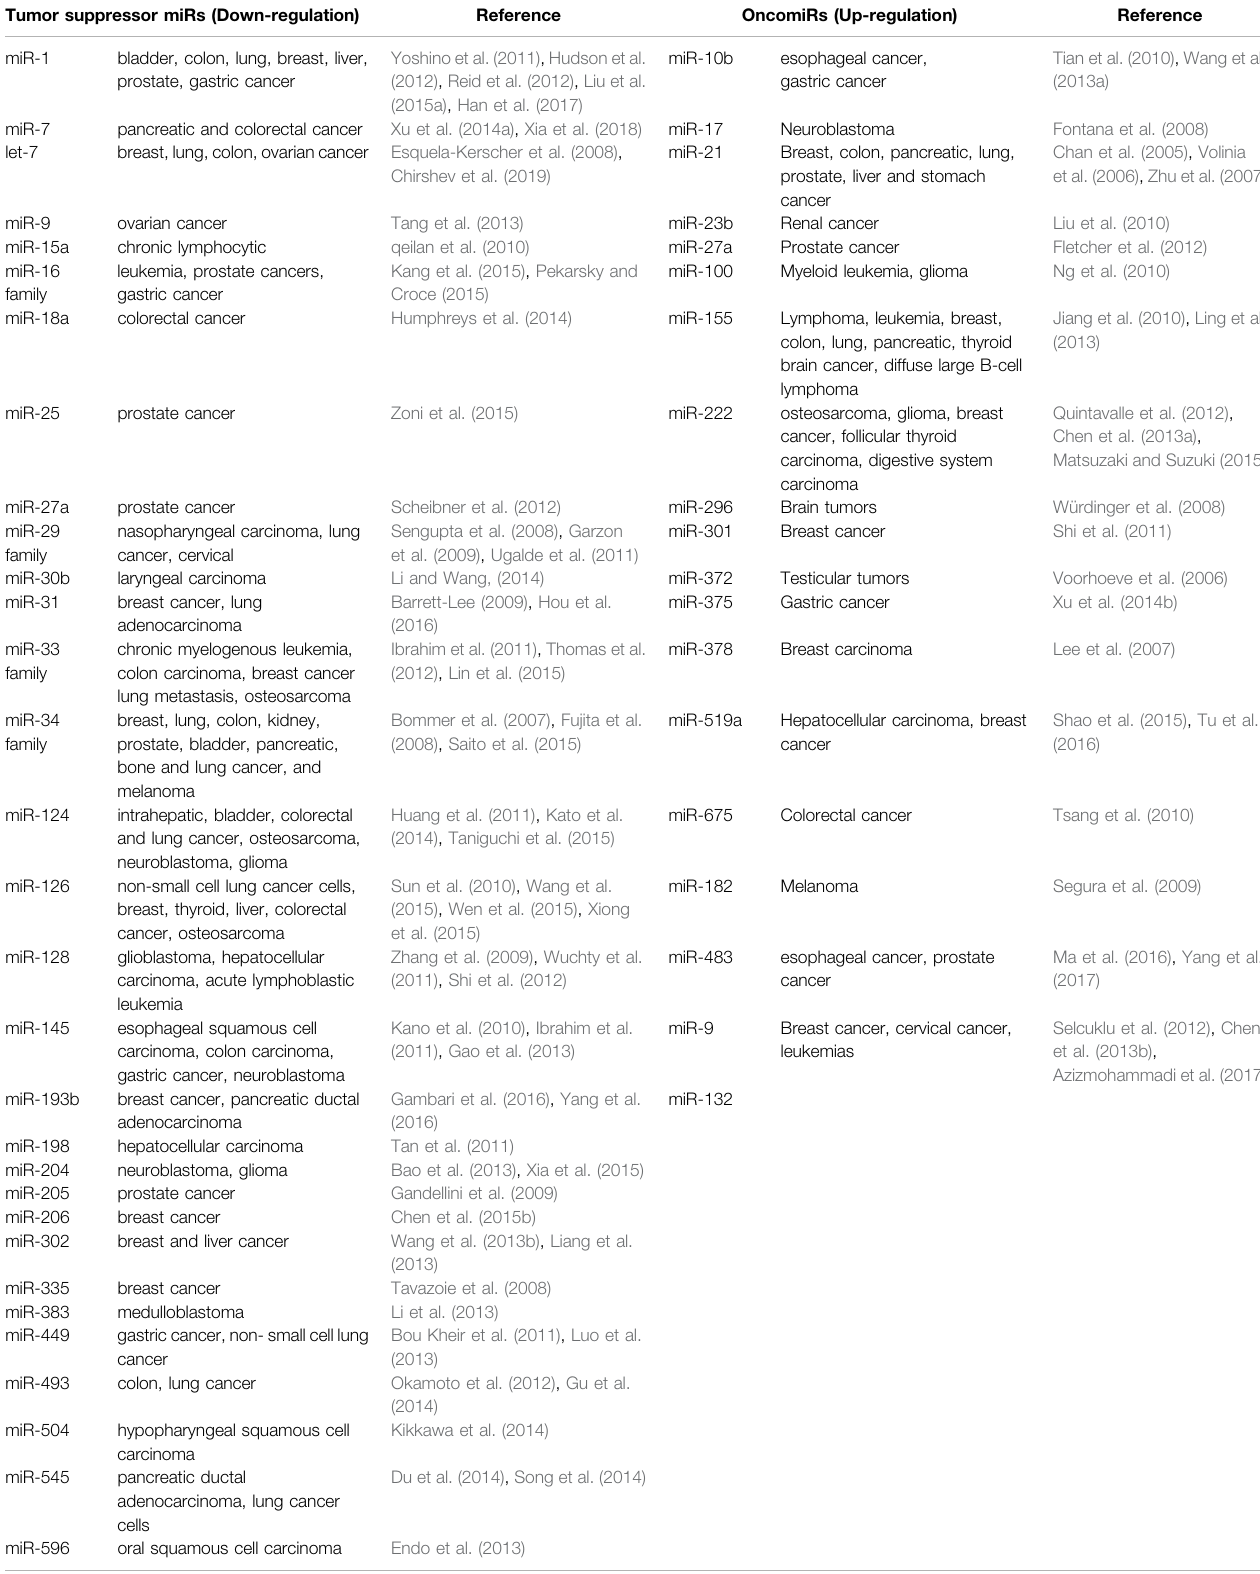
TABLE 1 | Aberrant expression of miRNA in